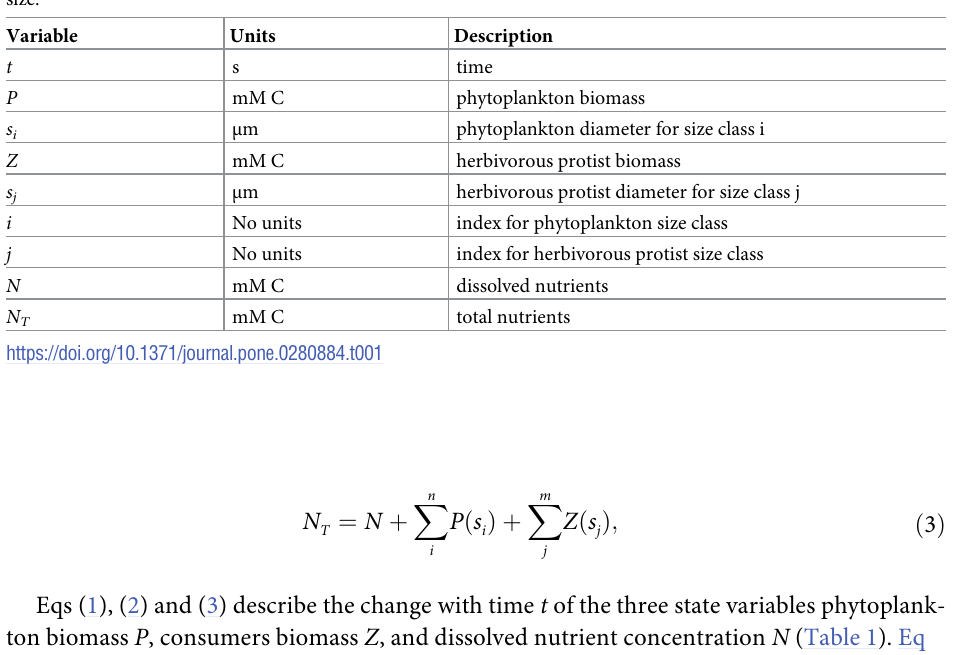
Table 1. Model state variables. Model variables for the phytoplankton biomass, grazer biomass, nutrients, time, and size.